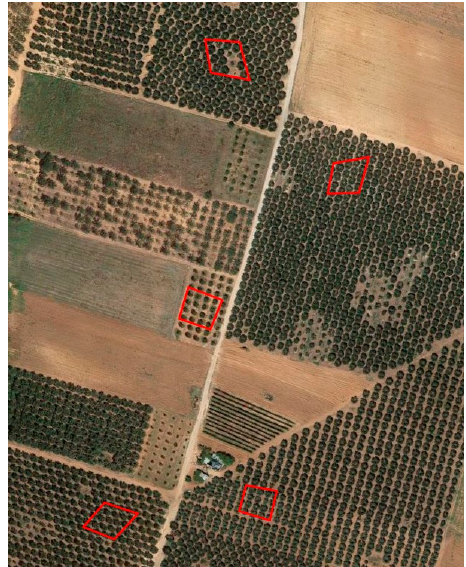
Figure 2. Polygons as samples in olive orchards in Halkidiki,